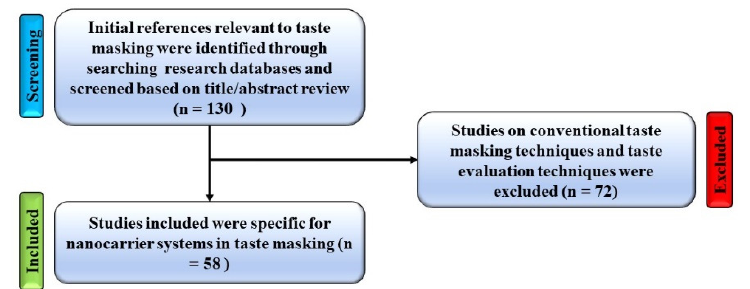
Figure 1. Study selection flow diagram. Table 1. Summary table of study characteristics.